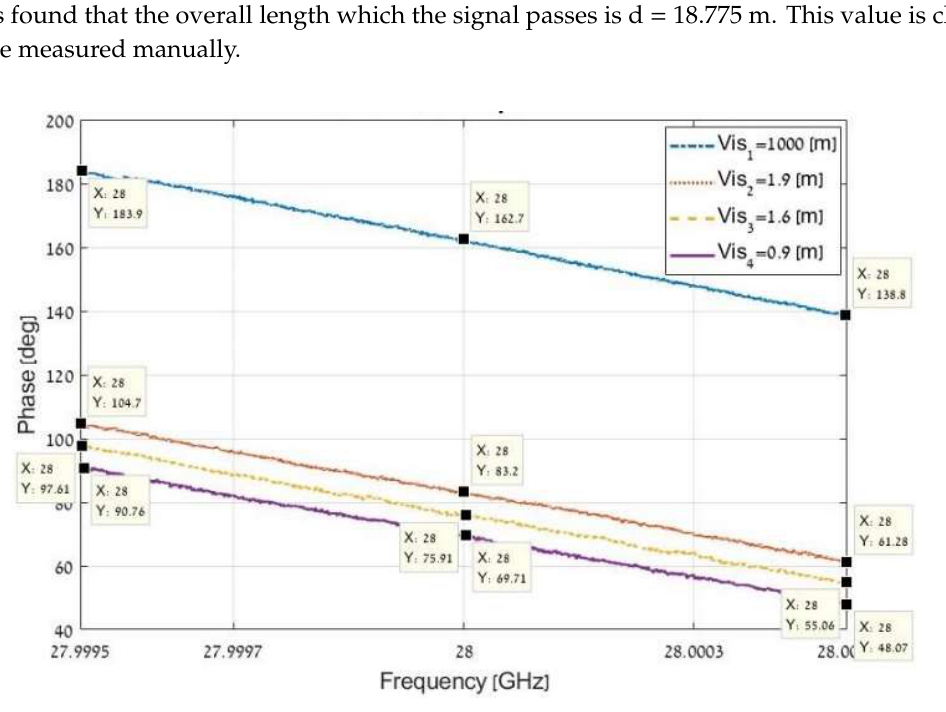
Figure 13. Graph of experimental results of received signal phase at 28 GHz for different fog